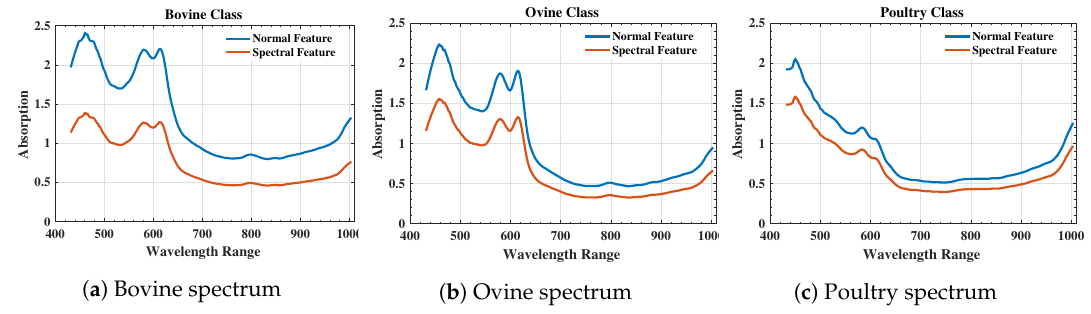
Figure 7. Difference in spectrum representations of Mb-based spectral features (spectral features) and classical absorption feature (normal Feature) of Bovine, Ovine and Poultry class minced meat.